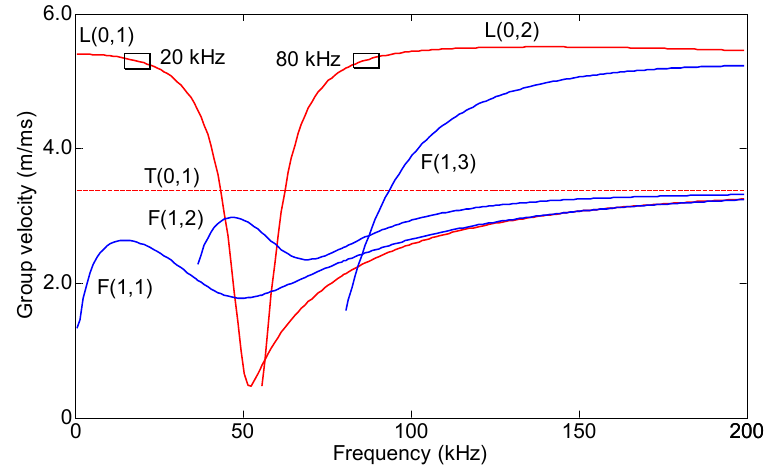
Figure 4. Group velocity dispersion curve of the steel pipe with a 38 mm outer diameter and a 5 mm wall thickness.